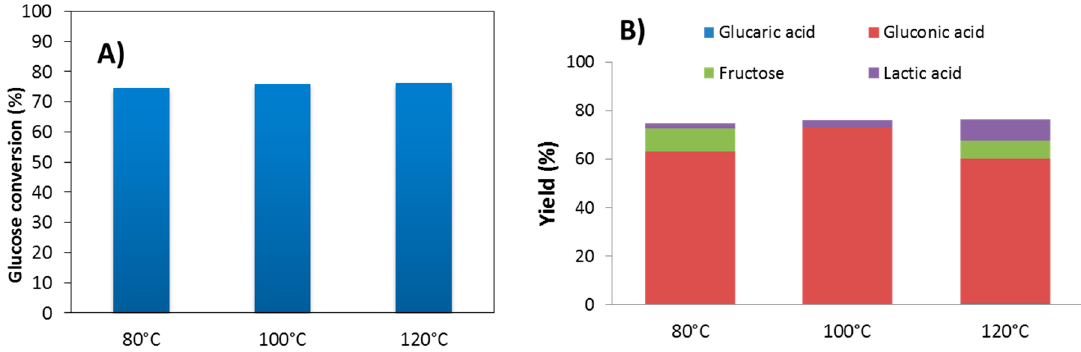
Figure 4. ( A ) Glucose conversion (%) as a function of the temperature over Au-Mt/Ce (600 rpm, 18 h); ( B ) yield (%).